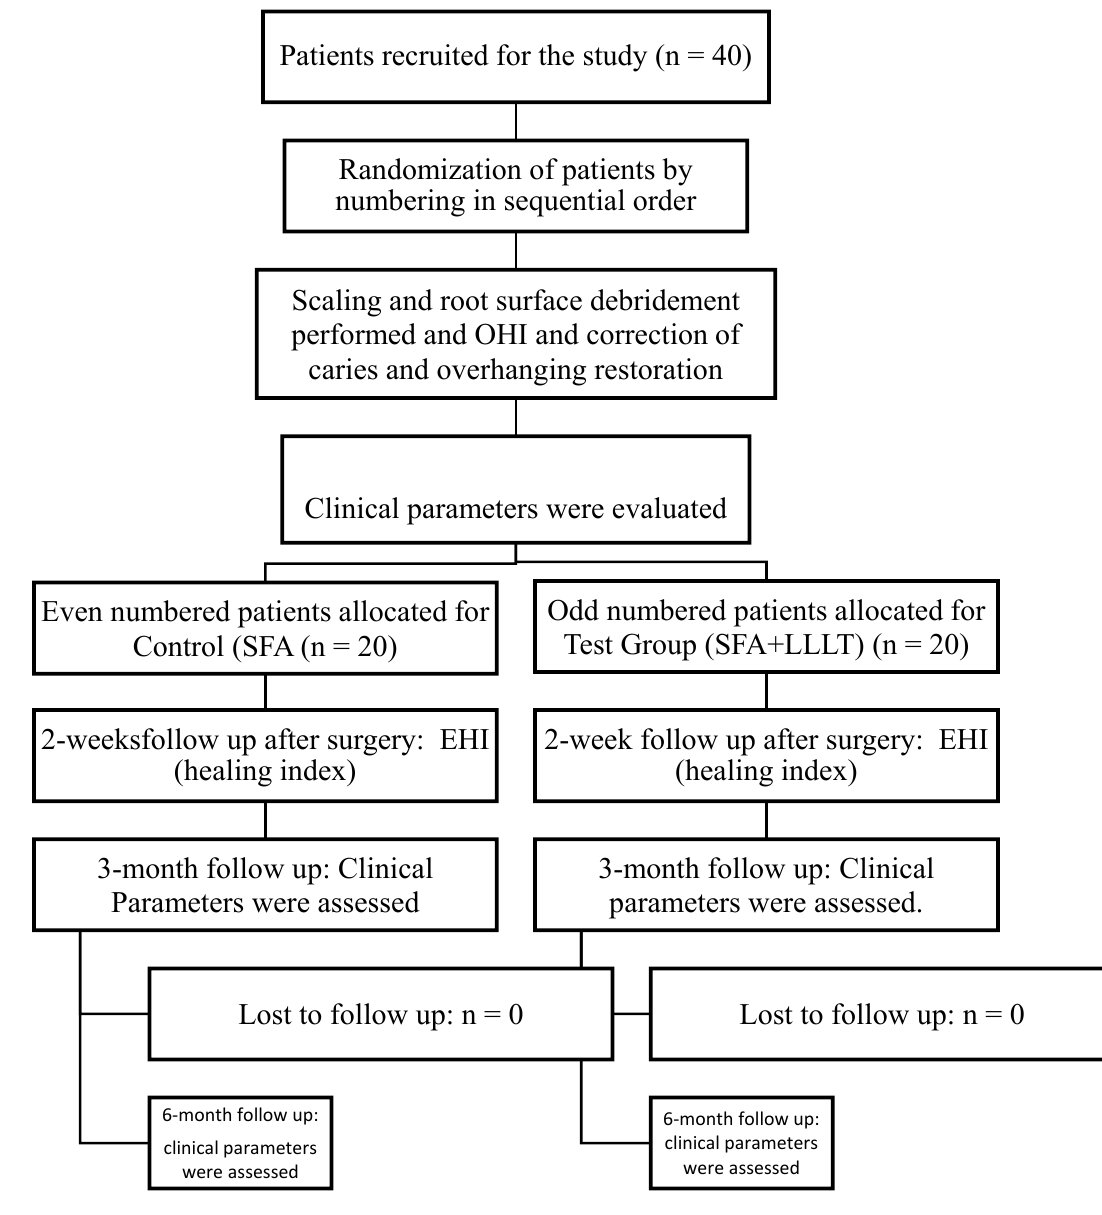
Figure 1. Workflow of study. Clinical parameters PPD—Probing Pocket depth, CAL—Clinical Attachment Loss, GBIGingival Bleeding Index, PlI—Plaque index.